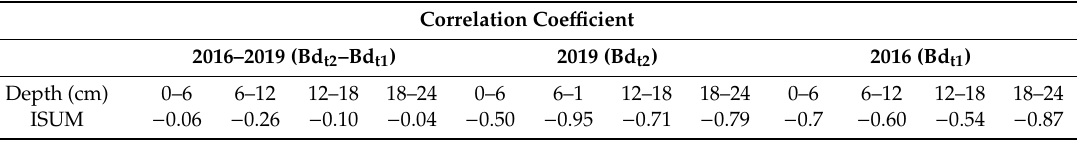
Table 3. Spatial correlation between raster maps obtained using ISUM and Bd.